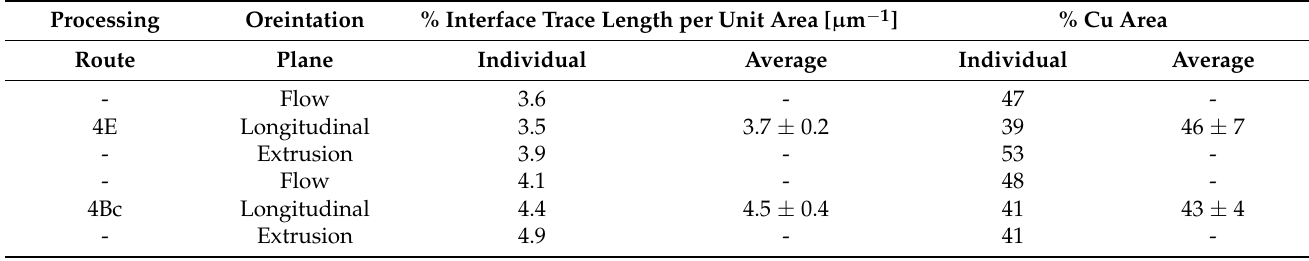
Table 2. Summary of phase boundary trace length per unit area and % area of Cu phase for Cu-Ta composites processed at 300 ◦ C.